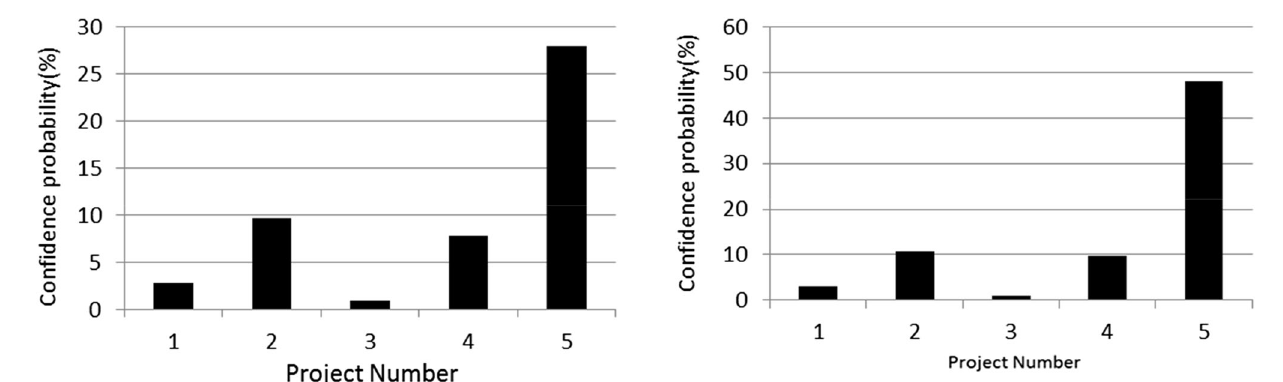
Fig. 9 Corporate confidence probability plotted against the project number for the case where the OWI is taken from the Kelly formal- ism for the five projects given in Table 4